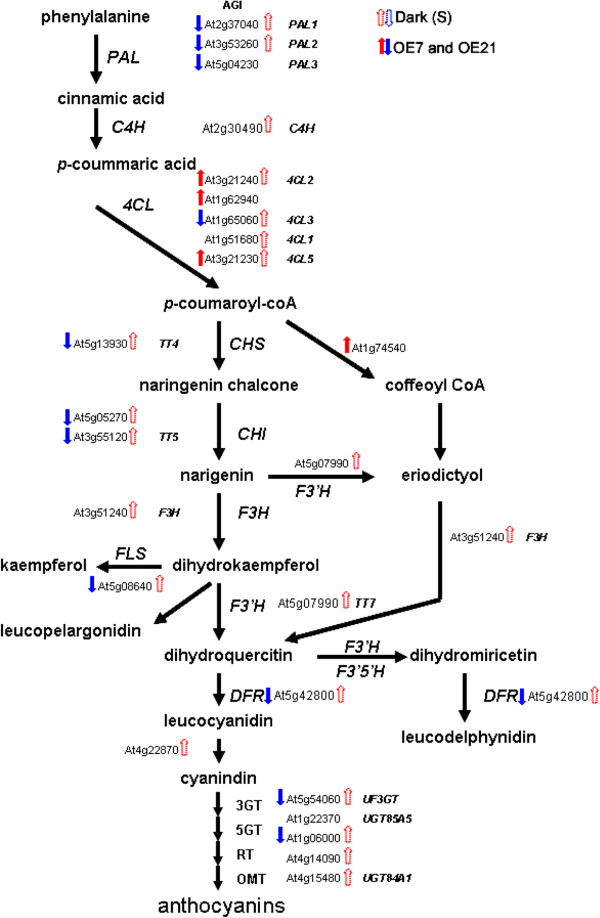
Genes of the anthocynain biosynthesis pathway are differentially affected by exogenous sucrose and endogenous sugars (AtPAP2 OE lines). Genes that were significantly altered (P < 0.05) are shown (arrows). Solid arrows indicate gene expression in OE lines while empty arrows showed the sucrose-modulated genes in dark grown WT seedlings (Dark (S)). Abbreviations are as follows: AGI, Arabidopsis Genome Initiative; C4H, cinnamate-4-hydroxylase; 4CL, 4-coumaroyl-CoA synthase; CHI, chalcone isomerase; DFR, dihydroflavonol 4-reductase; F3H, flavanone 3-hydroxylase; F3′H, flavonoid 3′-hydroxylase; F3′5′H, flavonoid 3′5′-hydroxylase; FLS, flavonol synthase; 3GT, 3-glucosyl transferase; 5GT, 5-glucosyl transferase; OMT, O-methyl transferase; PAL, phenylalanine ammonia-lyase; RT, rhamnosyl transferase; TT4, Transparent testa 4; TT5, Transparent testa 5; TT7, Transparent testa 7; UF3GT, UDP-Glc: flavonoid 3-O-glucosyltransferase.